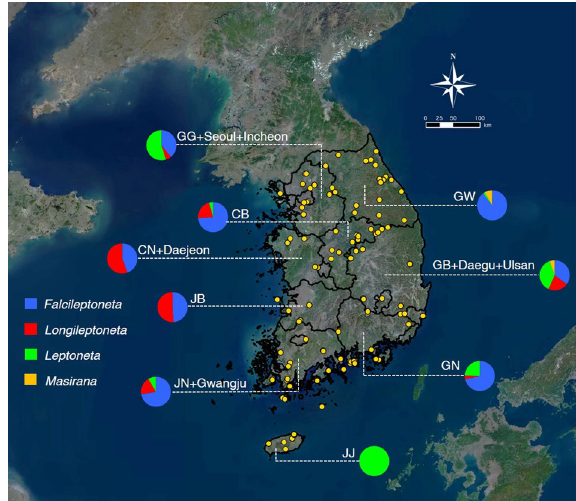
Figure 1. Map with sampling sites for collected specimens used in the present study. Pie charts indicate the proportion of each genus sampled from respective administrative localities. The abbreviations of each administrative district follow: GG, Gyeonggi-do; GW, Gangwon-do; CB, Chungcheongbuk-do; CN, Chungcheongnam-do; JB, Jeollabuk-do; JN, Jeollanam-do; GB: Gyeongsangbuk-do; GN, Gyeongsangnam-do; JJ, Jeju-do. The map was prepared using QGIS 3.22.1 (https:// www. qgis. org/ ko/